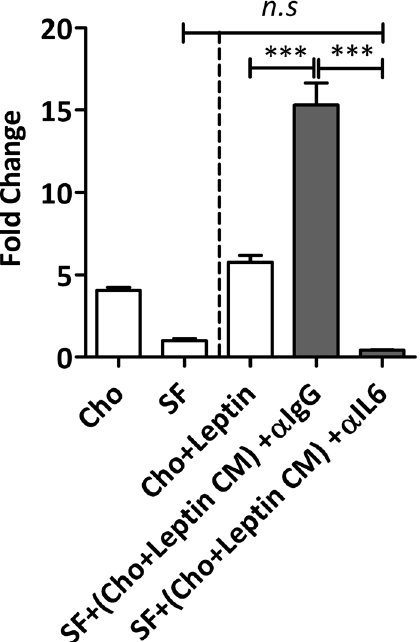
Figure 5. Depletion of IL-6 from chondrocyte conditioned media ablates IL-6 secretion from synovial fibroblasts. Synovial fibroblasts were cultured in chondrocyte conditioned media which had been treated with anti-IL-6 antibody or anti-IgG antibody during immunoprecipitation. Depletion of IL-6 in the chondrocyte conditioned media ablated the ability of fibroblasts to secrete elevated IL-6 titres in response to chondrocyte conditioned media. Data are mean ± SEM. Statistical significance was determined by one-way ANOVA *** p < 0.001.